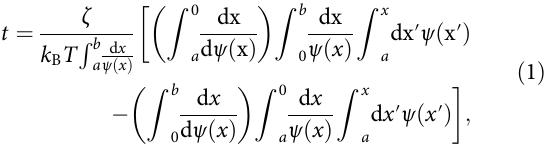
Fig. 5 Antibody selection through speci fi c binding and hopping. E. coli and S. fl exneri are trapped in the hotspot after they are conjugated with biotin-labelled anti- E. coli antibody and biotin-labelled anti- S. fl exneri antibody, respectively. When a streptavidin-conjugated microparticle passes through the trapped a E. coli and c S. fl exneri stained with speci fi c antibodies, the microparticle is anchored to the bacterium through the very strong biotin – streptavidin interaction. The microparticle and bacterium hop together to another hotspot. When b E. coli and d S. fl exneri are trapped in the hotspot after they are incubated with non-speci fi c antibodies, the streptavidin-conjugated microparticle hops to another hotspot without binding with any bacterium due to the unsuccessful labelling of biotin. Experimental observation of the streptavidin-coated microparticle hopped with e E. coli conjugated with anti- E. coli antibody, and f passed away from bare E. coli due to unsuccessful conjugation of non-speci fi c antibody (anti- S. fl exneri